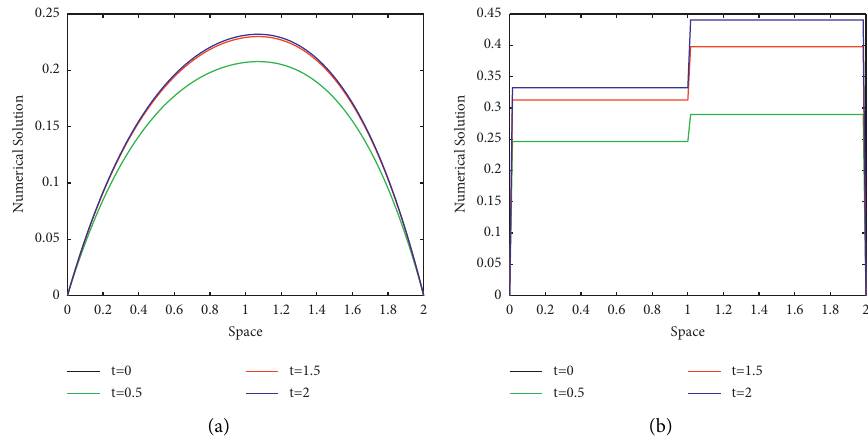
Figure 5: Line plots for the numerical solution of Example 3 for N � 128 and M � 64. (a) [ ε � 2 0 ], (b) [ ε � 2 − 14 ].